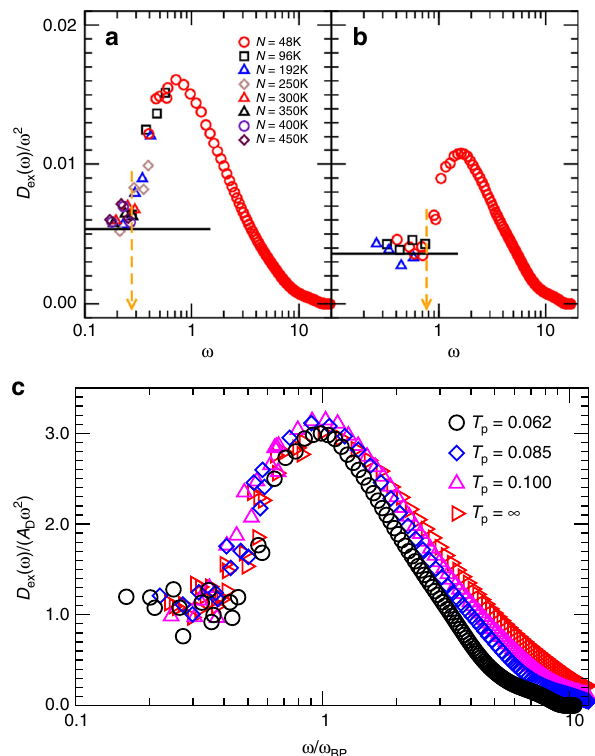
Fig. 5 Density of states for extended modes. Reduced density of states for extended modes, D ex ( ω )/ ω 2 , at parent temperatures T p = ∞ ( a ) and 0.062 ( b ), for systems with different sizes. The black line in each panel indicates the Debye level A D while the vertical arrow marks the frequency, where D ω )/ ω 2 starts to deviate from A ex ( D . c Rescaled version of the same data using the Debye level (vertical axis) and the boson peak frequency ω BP